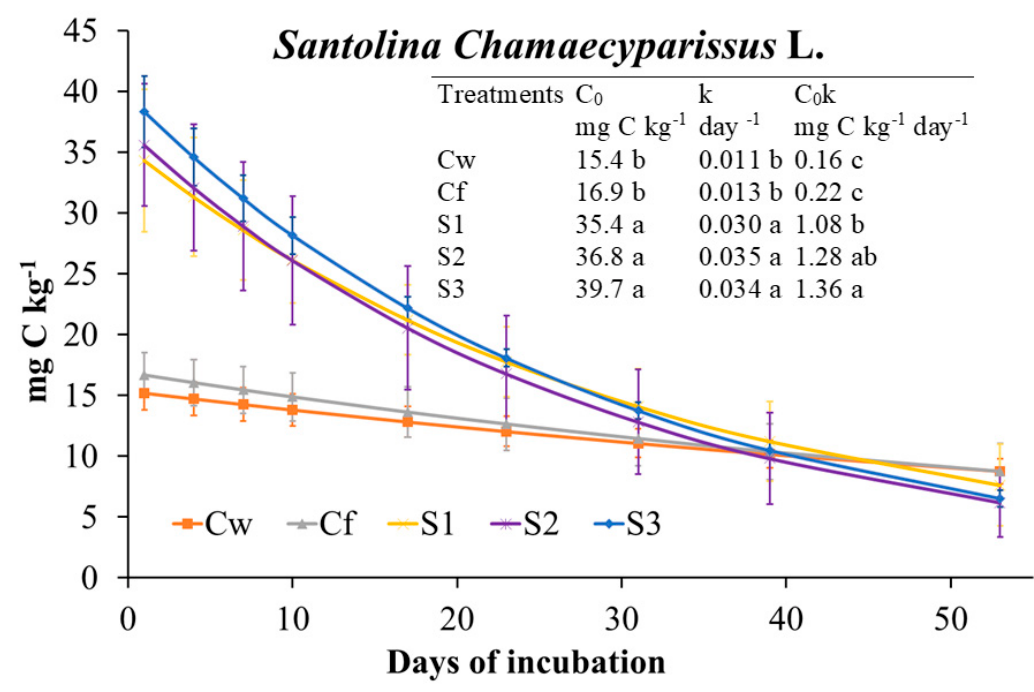
Figure 6. Microbial respiration rate fitted to the exponential first order decay function (Mineralized C = C 0 e − kt ) and derived parameters (C 0 , biological available C; k, turnover constant rate; C 0 K, initial potential rate of C mineralization) determined on soil treated with Santolina chamaecyparissus L. essential oil (EO) applied by irrigation. Treatments were: Cw (no Fitoil and EO application), Cf (0.03 µL Fitoil g − 1 of soil and no EO application), T1 (0.03 µL Fitoil g − 1 of soil and 0.31 µL EO g − 1 of soil), T2 (0.03 µL Fitoil g − 1 of soil and 0.67 µL EO g − 1 of soil), and T3 (0.03 µL Fitoil g − 1 of soil and 0.93 µL EO g − 1 of soil). Reported results are means ( n = 4). Bars indicate the standard deviations. Lower case letters indicate significant differences among treatments.